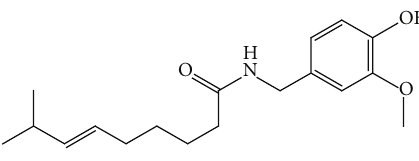
Figure 1: Molecular structure of